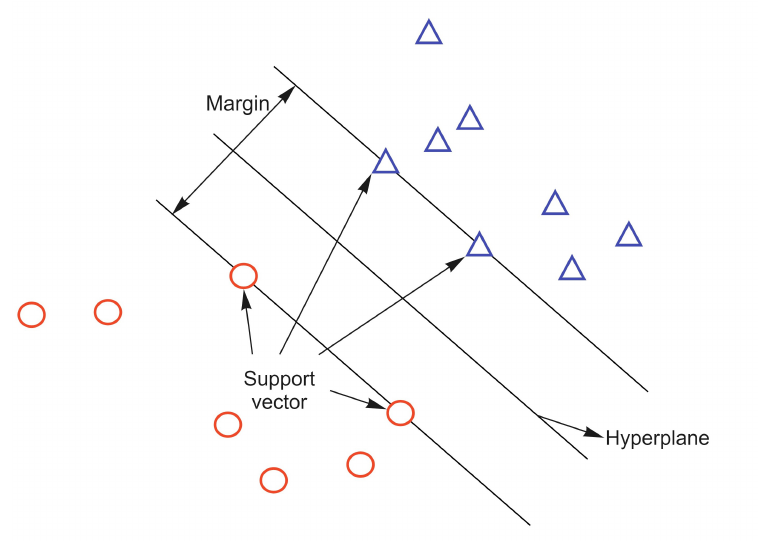
Figure 2. A binary classification of